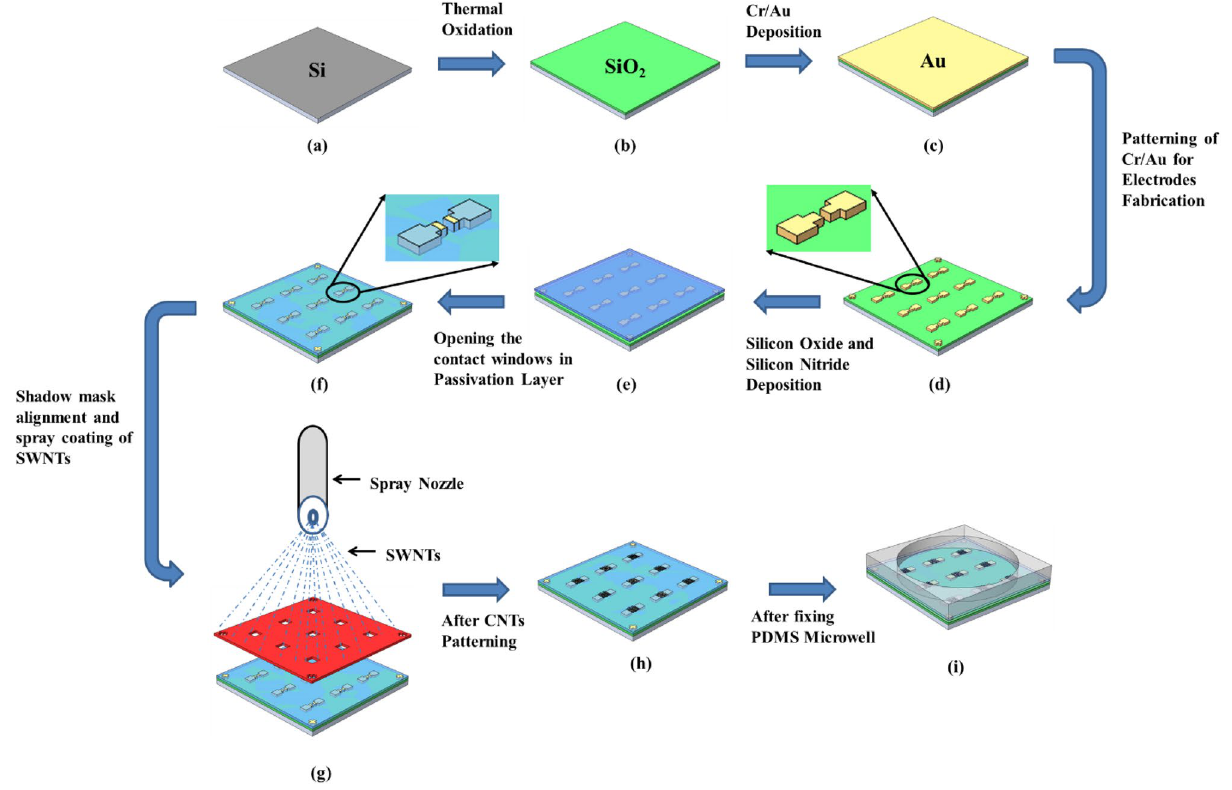
Figure 2. Schematic diagram, showing the fabrication of 3 × 3 array of LG-CNTFETs.